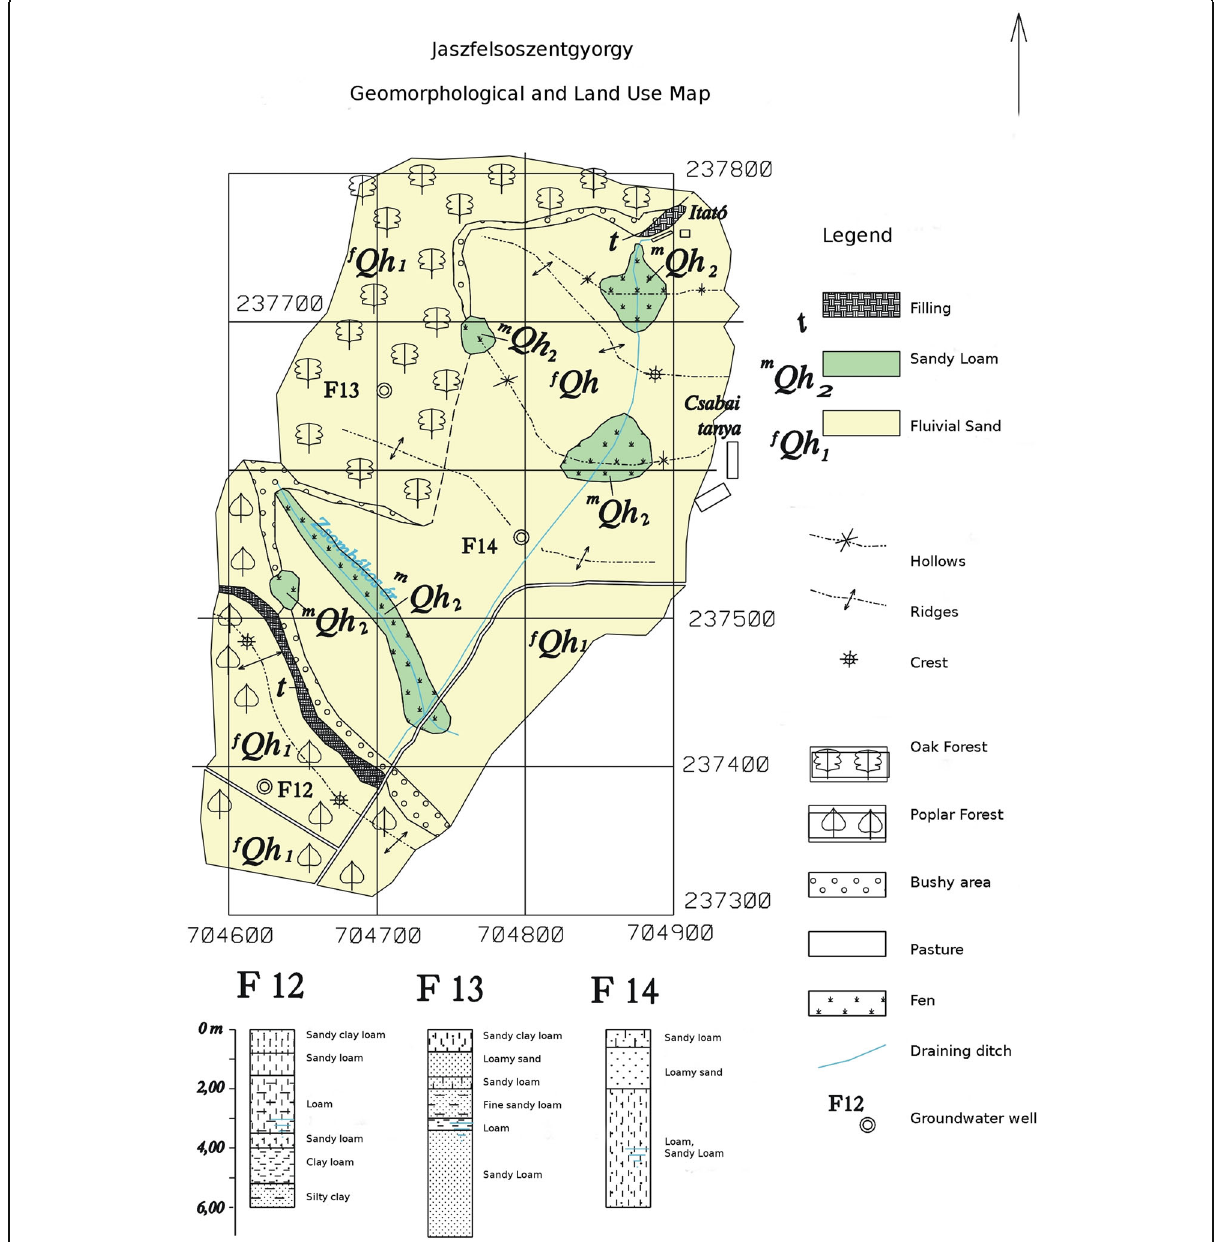
Fig. 2 Geo-morphological map with land use and location of groundwater wells